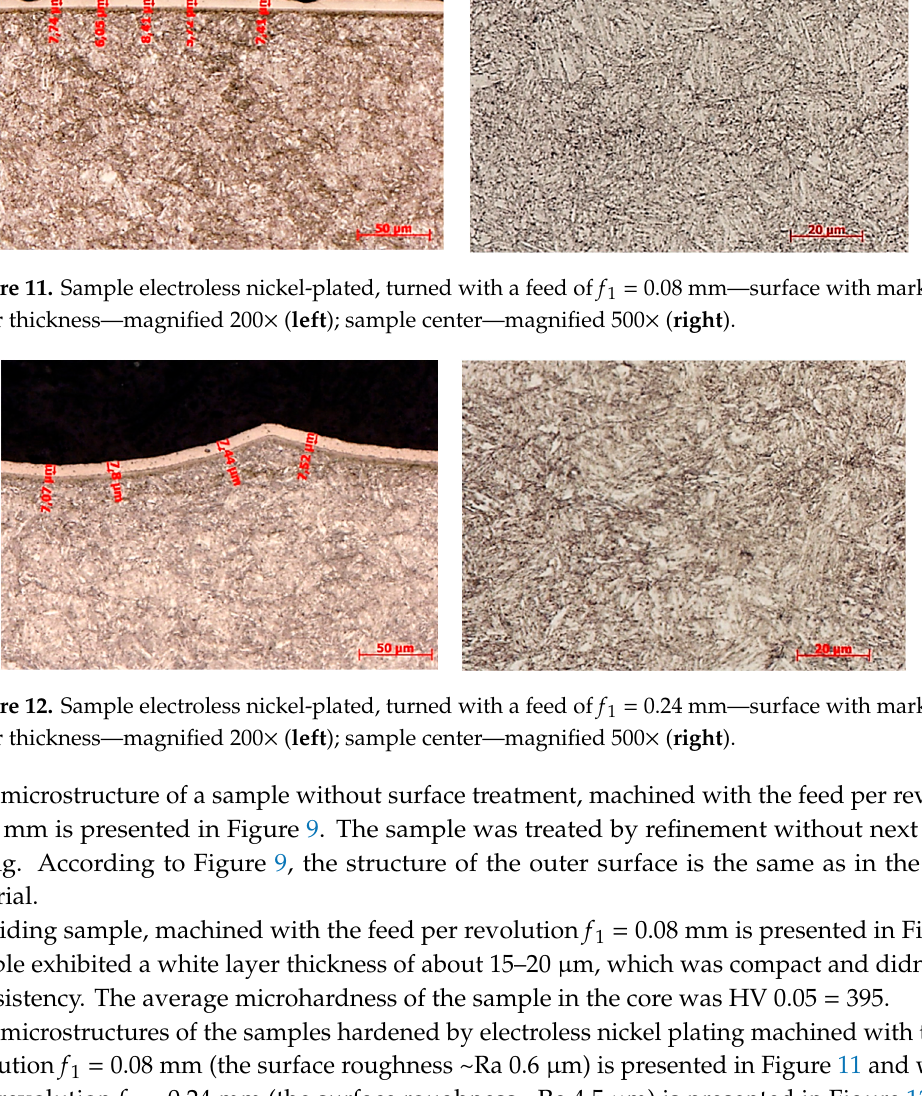
Table 3. Microhardness (HV 0.025) of fine and roughly turned samples with Ni coating deposition.